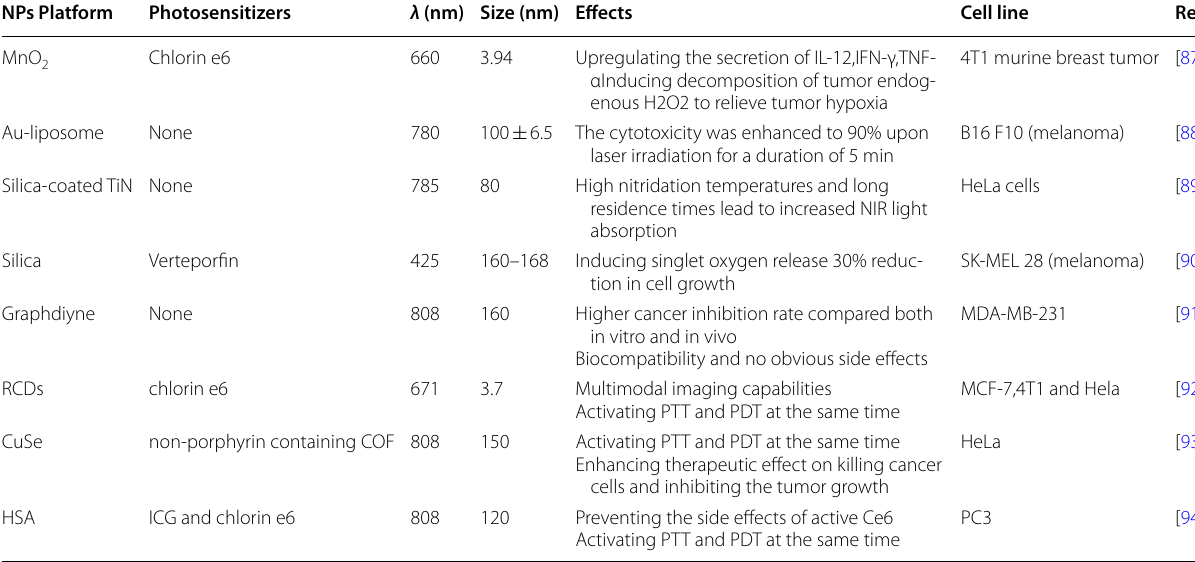
Table 5 Typical NPs platforms used in PDT and